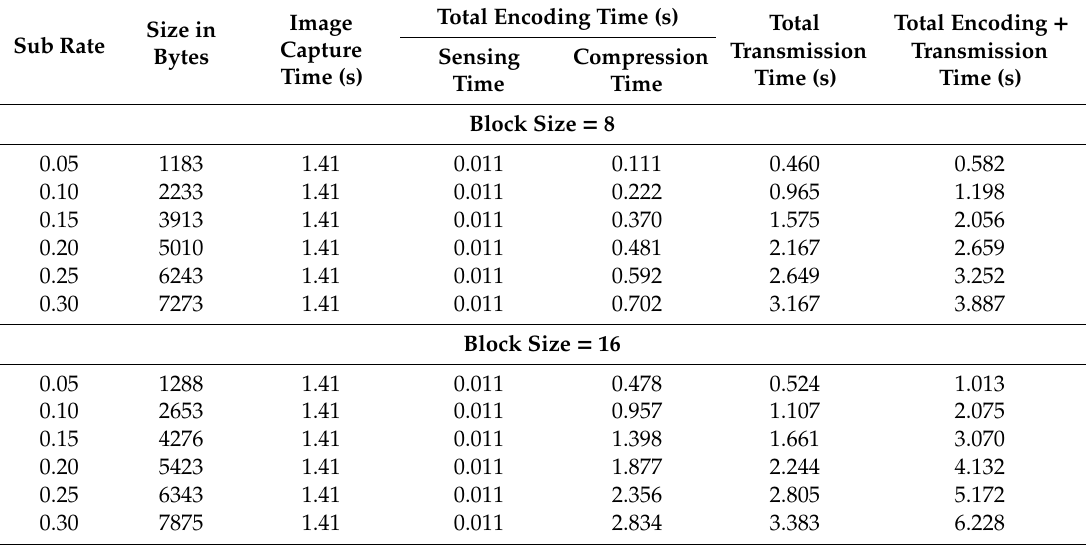
Table 1. Time taken to complete the encoding and transmission at various block sizes and subrates.